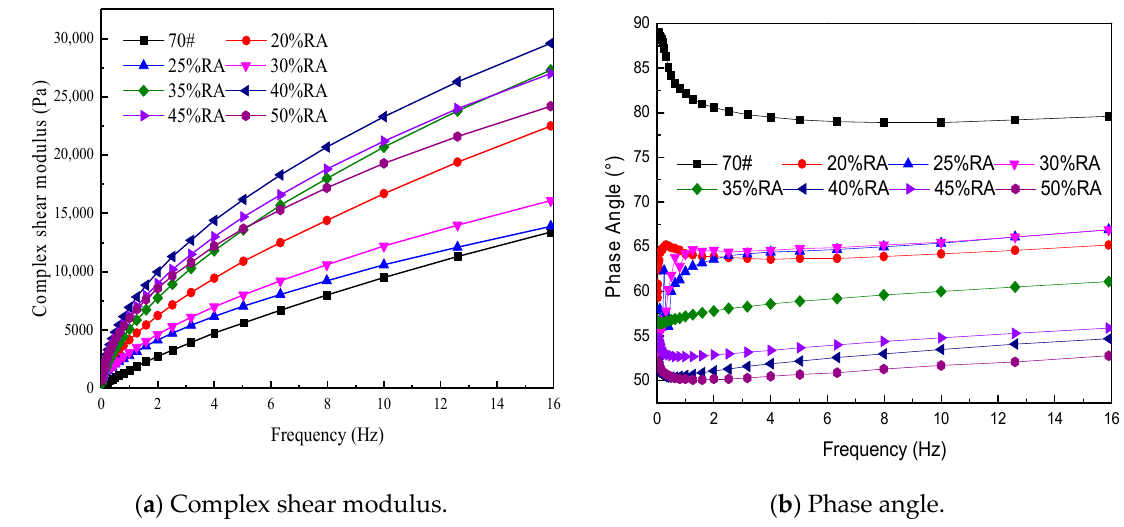
Figure 6. Complex shear modulus and phase angle. ( a ) Complex shear modulus ( b ) Phase angle